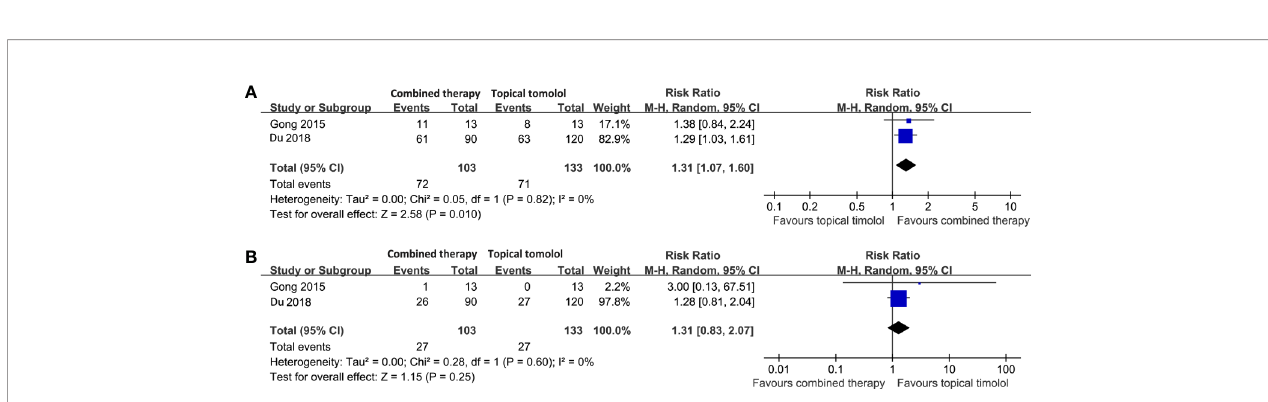
FIGURE 3 | Forest plots for the meta-analyses comparing the ef fi cacy and safety outcomes between the combined therapy and oral propranolol for treating IH. (A) , response rate after treatment; (B) , incidence of